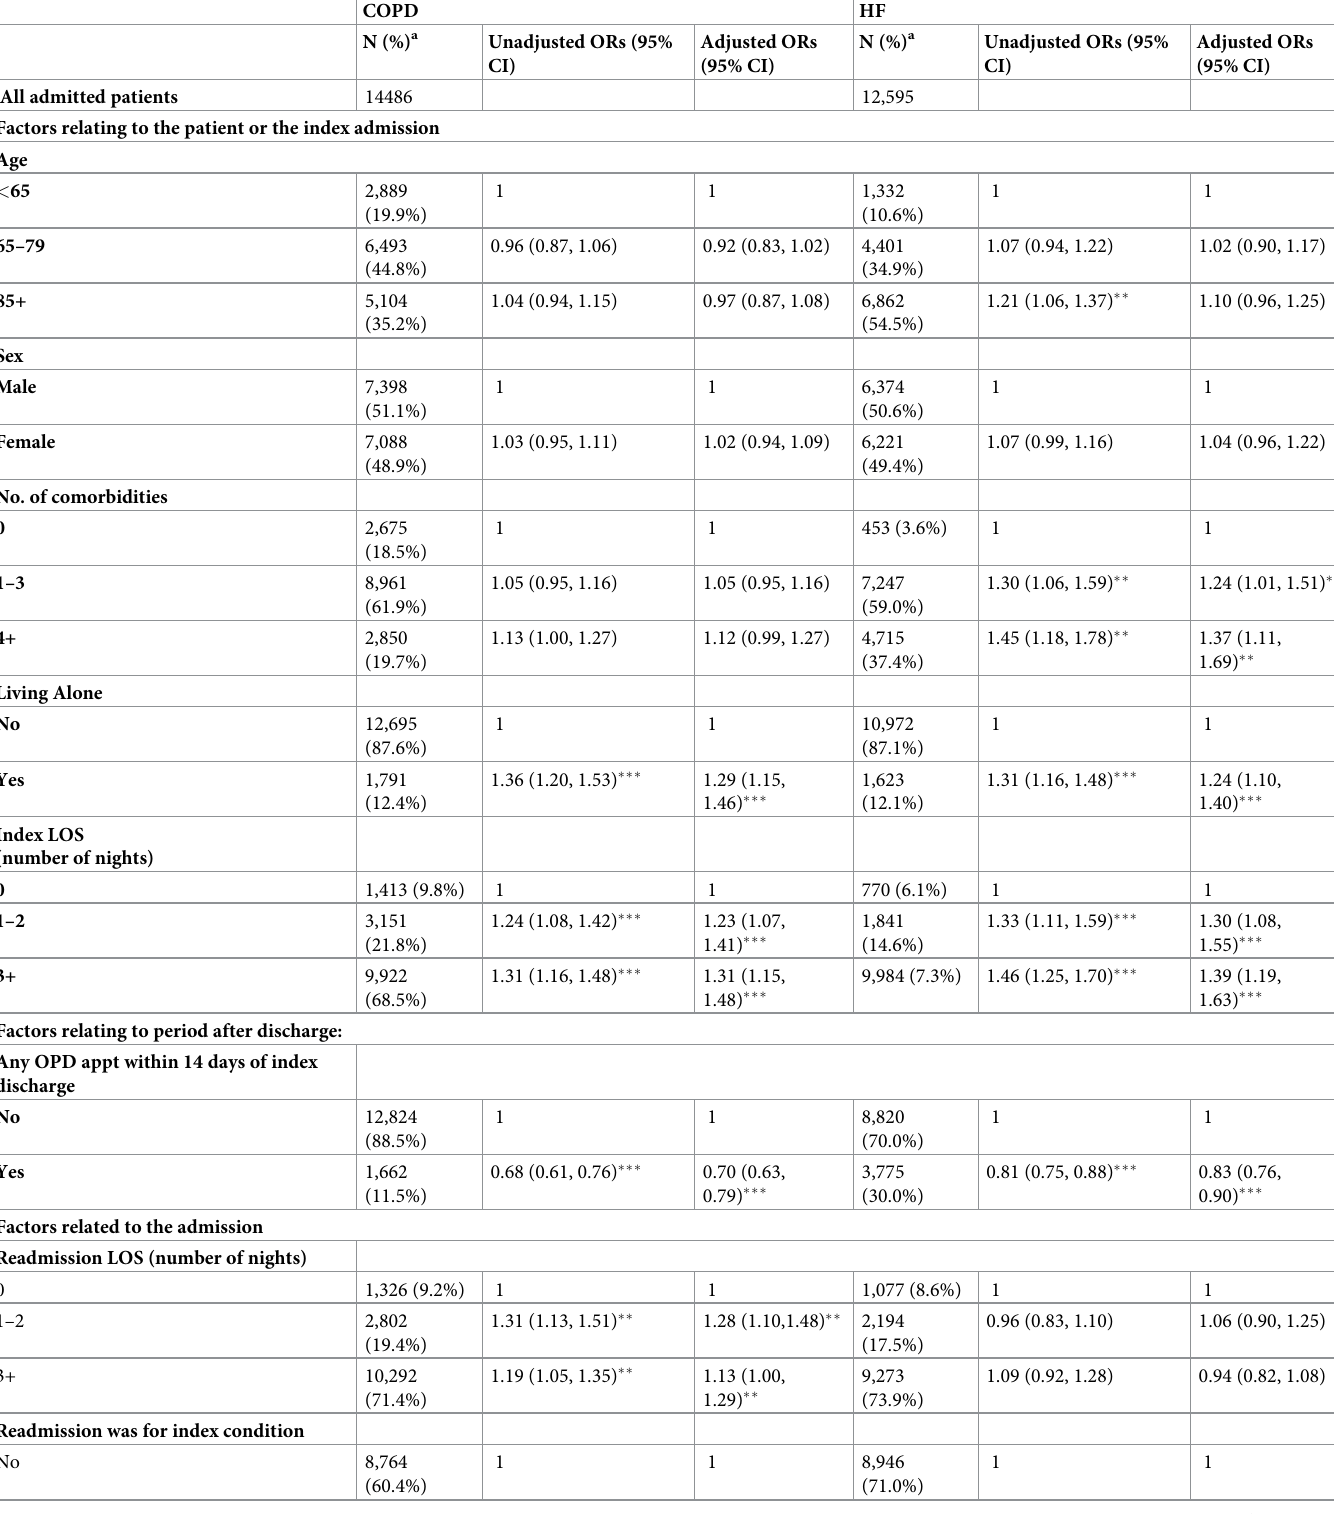
Table 4. Factors associated with route of readmission. Odds ratios (ORs) presented are the odds of being admitted through the ED compared to ‘other